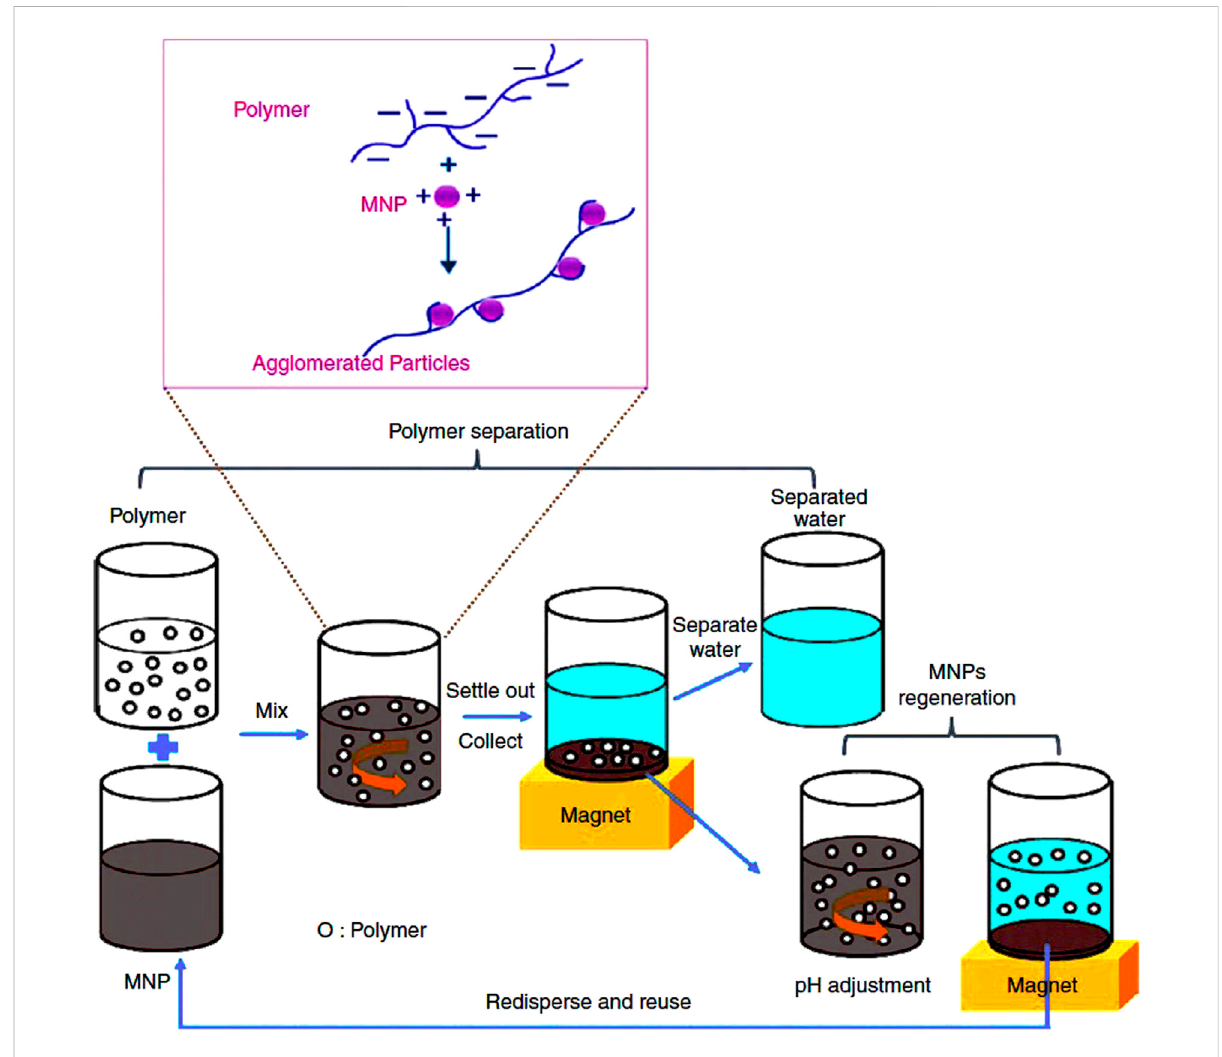
FIGURE 20 Schematic of removal and recycle of polymer and magnetic nanoparticles (based on Ko et al., 2017).